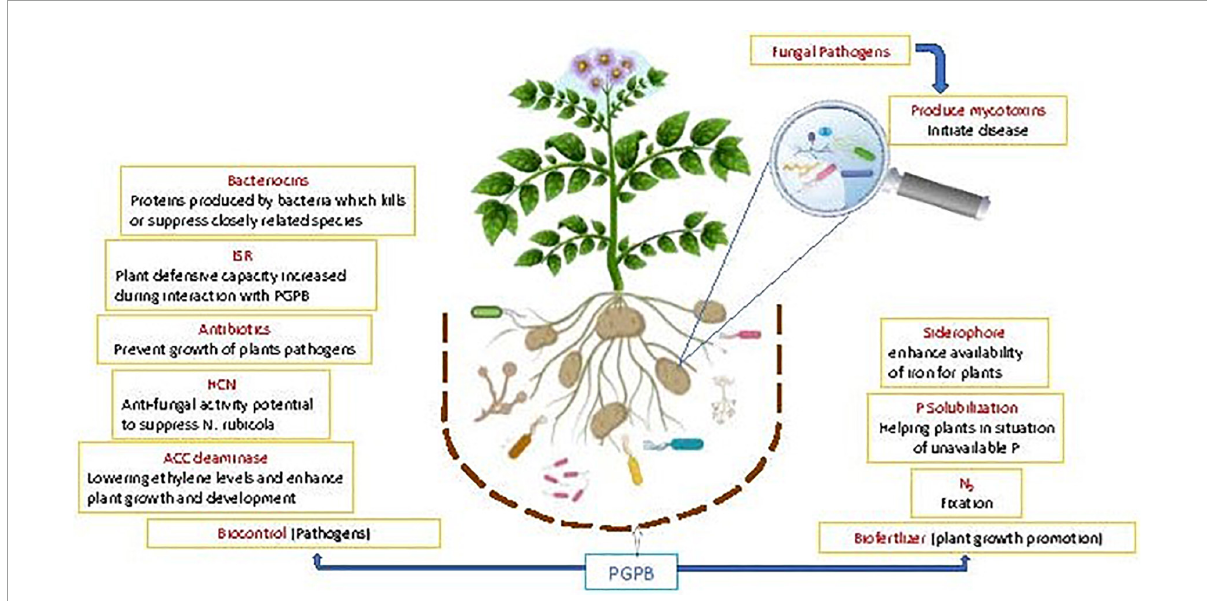
FIGURE3 Schematic representation of the beneficial potential of PGPB in plant growth promotion and biological control of diseases: greater focus on fungal disease